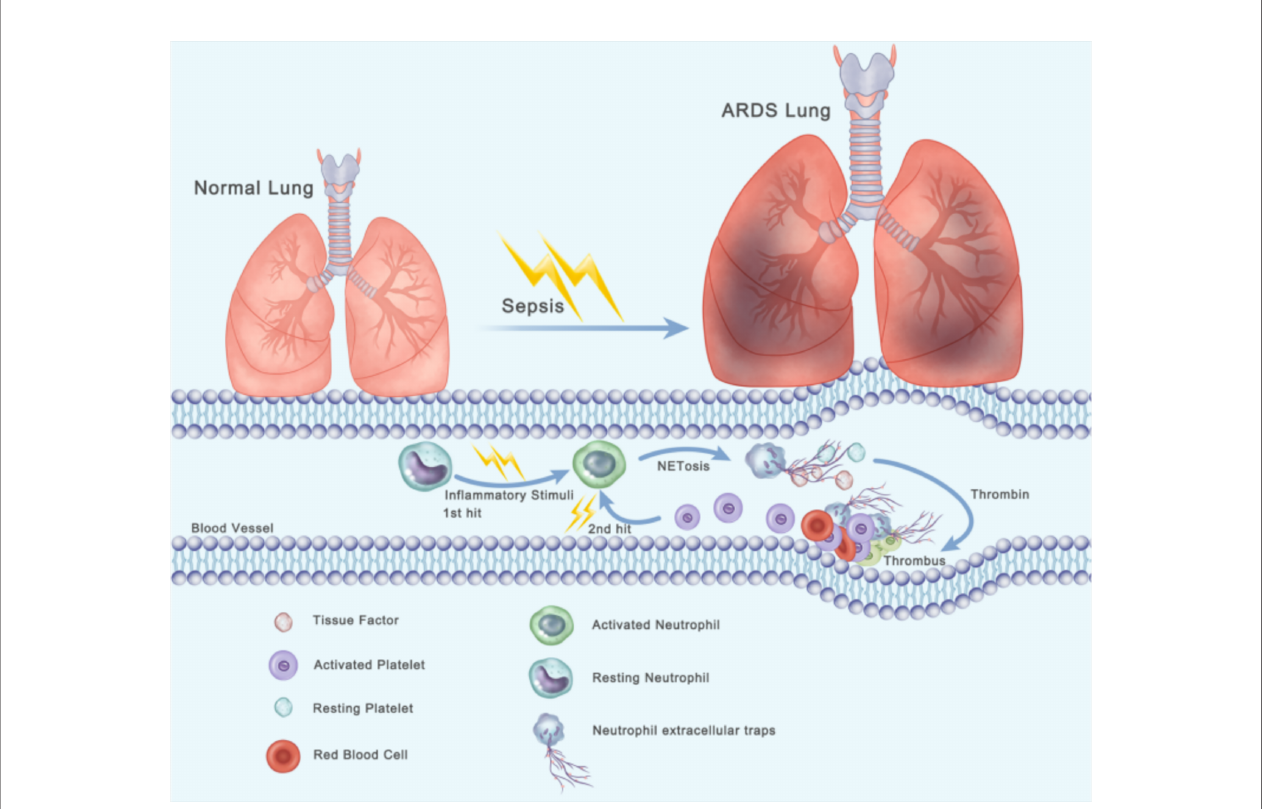
FIGURE 7 | Two-hit procedures of thrombosis formation initiated by NETs and activated platelets lead to the progression of ARDS. When sepsis-mediated ARDS occurs, neutrophils are activated and then form TF-enriched neutrophil extracellular traps in pulmonary blood vessels ( fi rst step), resulting in thrombin generation. Platelets are activated by thrombin and then interact with neutrophils, which lead to formation of TF-enriched NET (second step).Thereby creating a vicious cycle that causes massive thrombosis